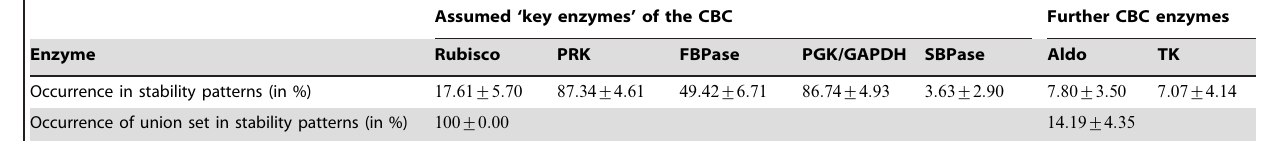
Table 3. CBC enzyme occurrences in the derived patterns.